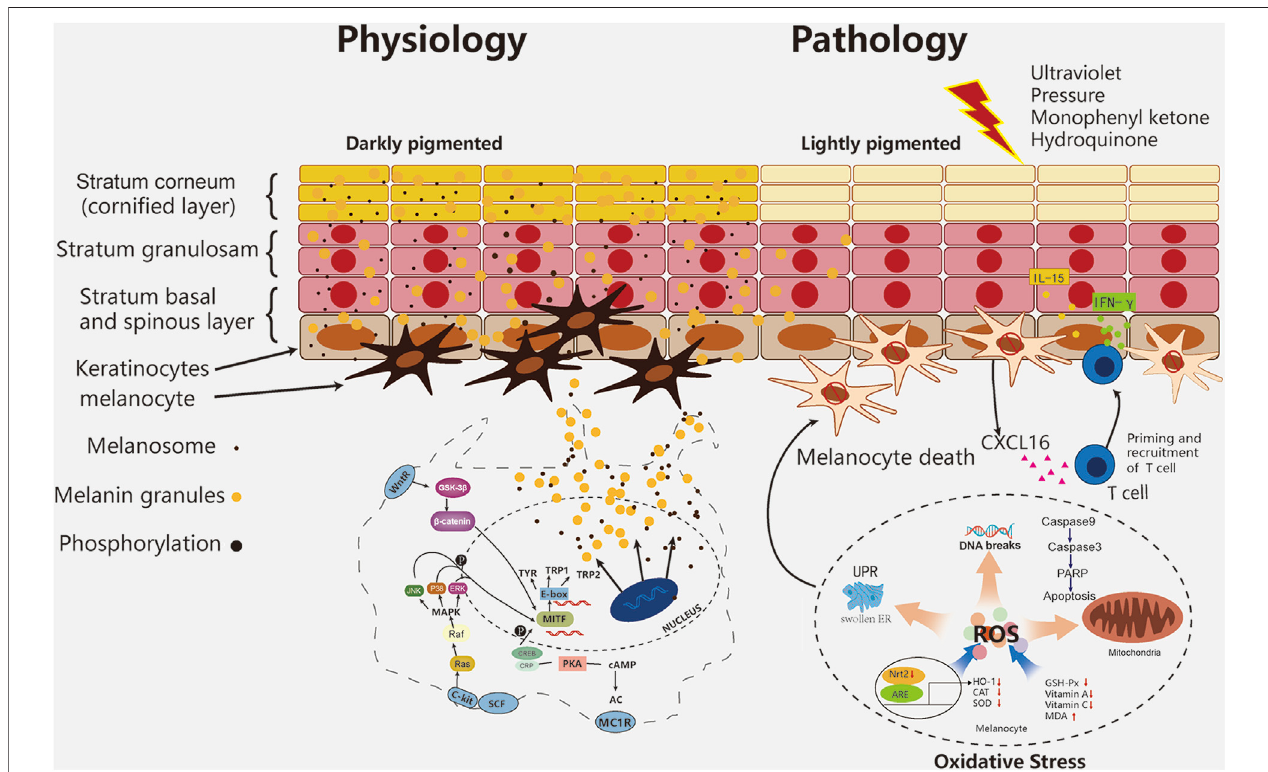
FIGURE 1 | Melanocyte pathophysiology in